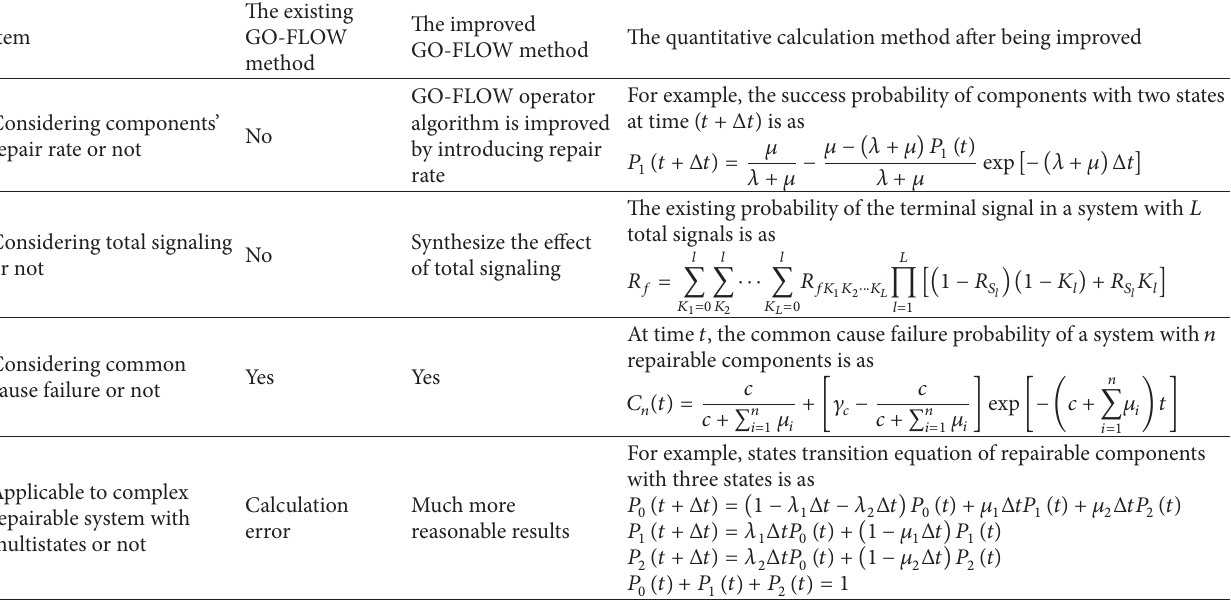
Table 1: The improved GO-FLOW method used in NPP’s power supply